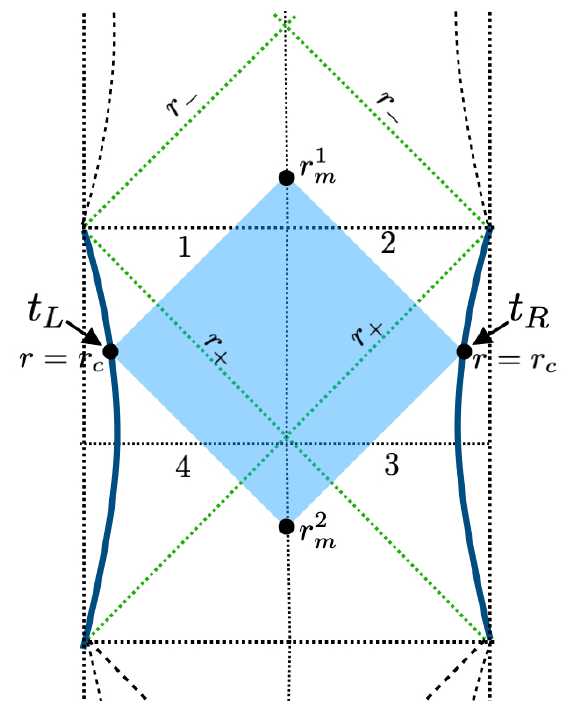
Figure 8 . AdS 2 solution of the JT model and the WDW patch. Physical boundary is depicted with a blue curve. The outer and inner horizons appear at r = r JT